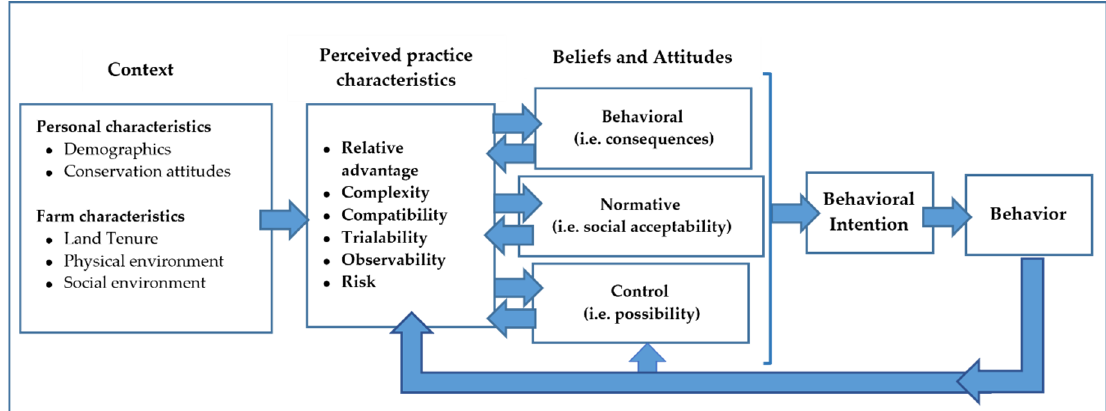
Figure 1. Conceptual model, adapted from Reimer [28] and Arbuckle and Roesch-McNally [29] .